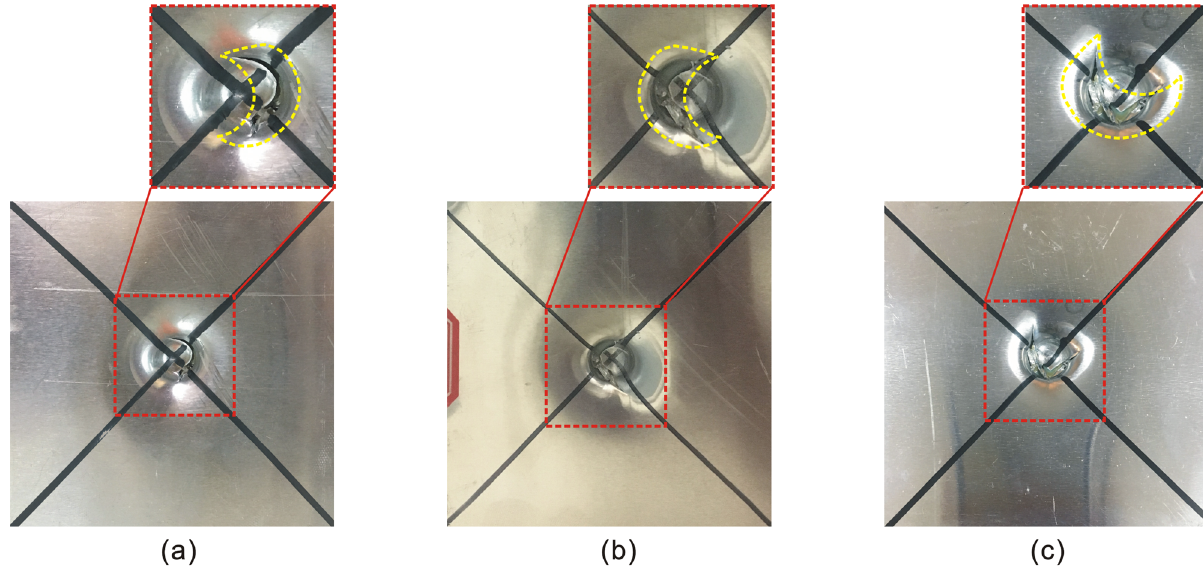
Figure 9: Damage of specimens with depth of 7.8 mm after QSI: ( a ) specimen 1, ( b ) specimen 2, and ( c ) specimen